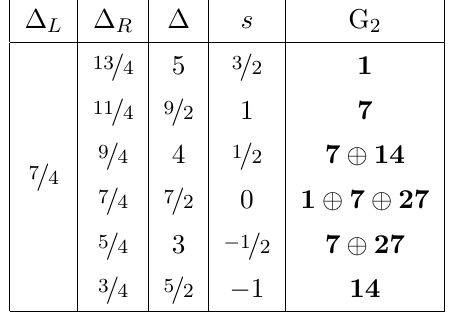
Table 21. Mass spectrum for the G(3) solution with is SO(7) G 2 (cid:2)